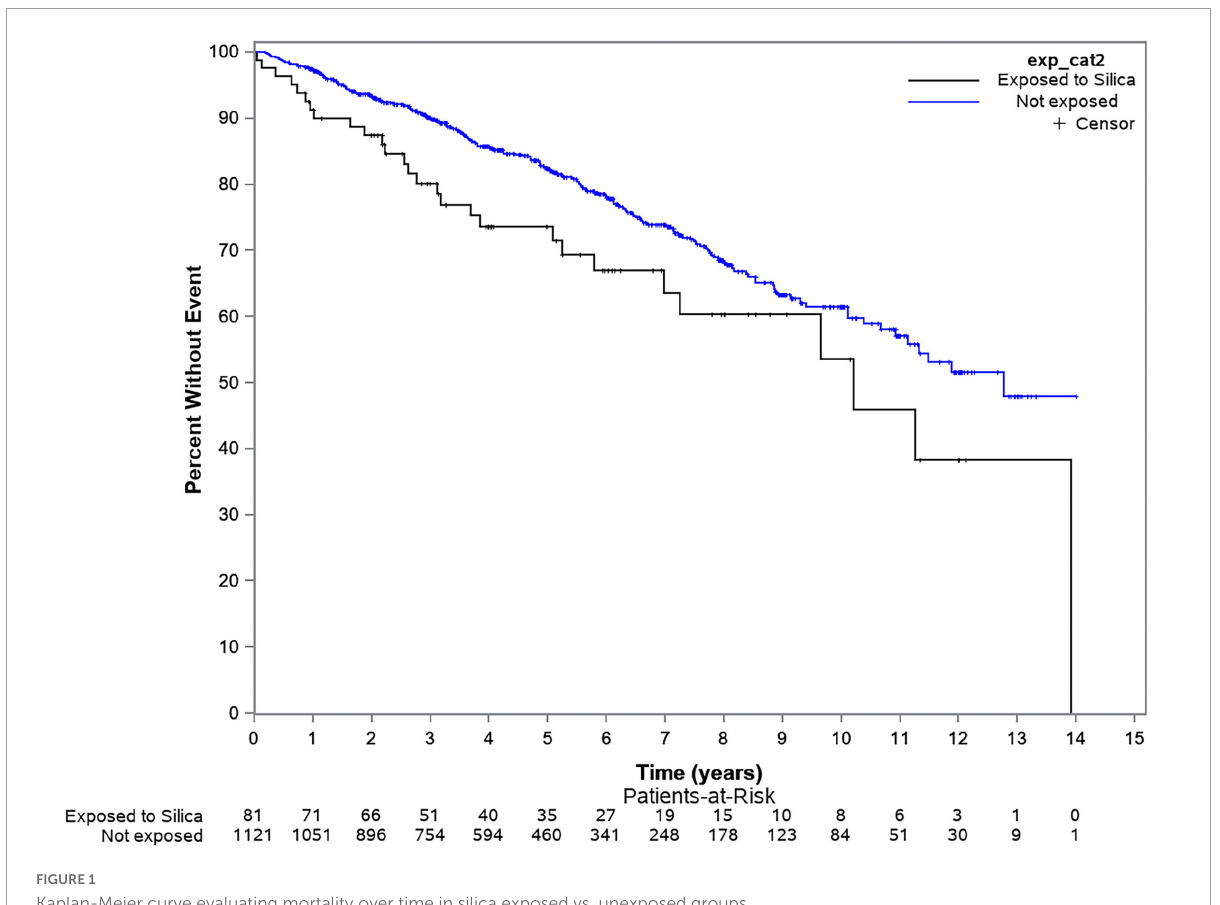
FIGURE1 Kaplan-Meier curve evaluating mortality over time in silica exposed vs. unexposed